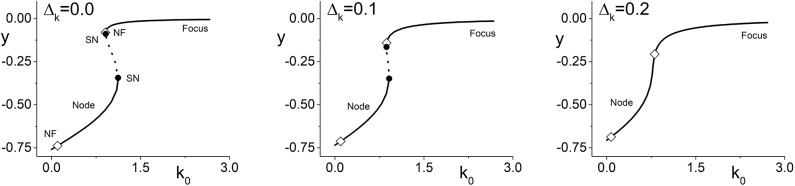
Case 1: One-dimensional bifurcation diagrams showing y = Im(z) vs. the parameter k0, which is the center of the coupling strength distribution. The panels show the diagrams for increasing values of Δk, the width of the coupling strength distribution. Stable (unstable) equilibria are represented by solid (dotted) lines, and are nodes or foci as indicated. Open diamonds are node-focus transitions. For Δk = 0.0, two saddle-node bifurcations are seen (solid black circles). These merge and disappear as Δk increases, but the node-focus transitions remain. The other parameters are η0 = −0.3, Δη = 0.08, and n = 2.